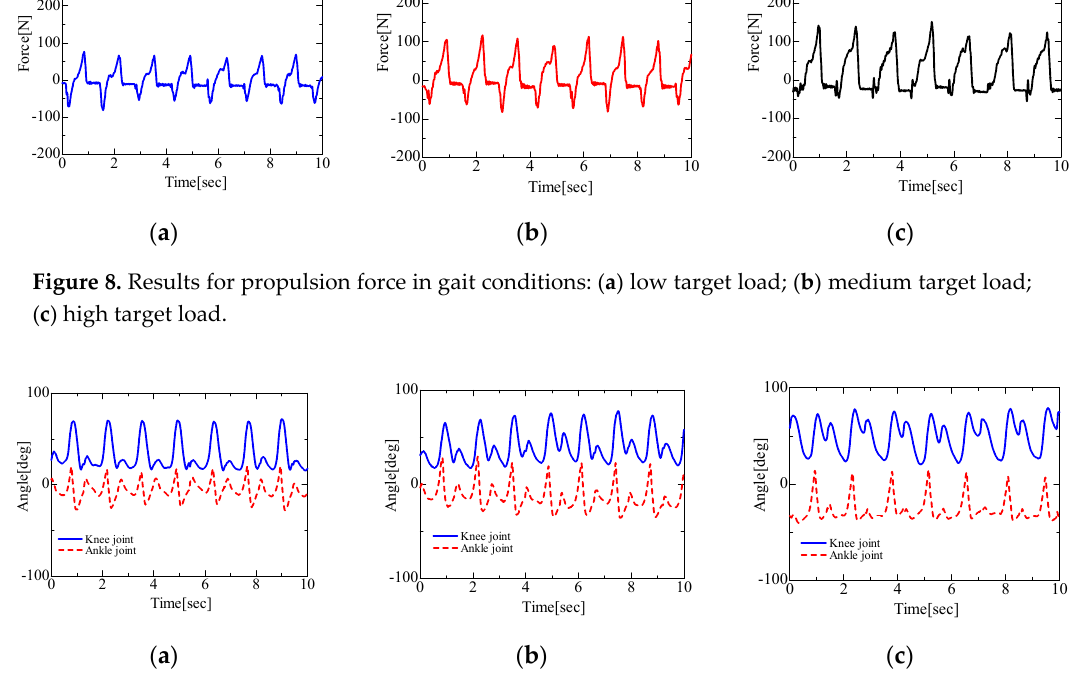
Figure 9. Results for right joint angles in gait conditions: ( a ) low target load; ( b ) medium target load; ( c ) high target